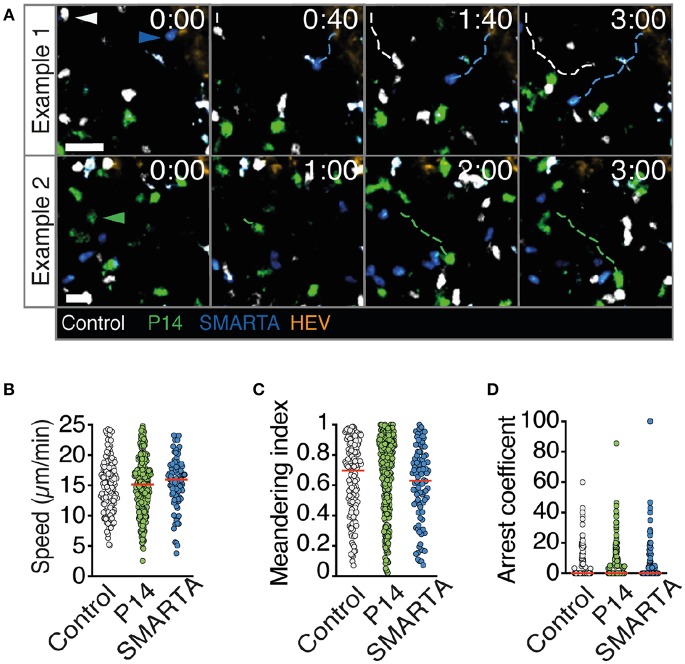
T cell motility parameters in non-infected LNs. (A) Representative 2PM images of control (white), P14 (green), and SMARTA T cell tracks (blue) with HEV (orange) at 96 h after adoptive T cell transfer. Arrowheads point the tracked cell: control (white), P14 (green), and SMARTA (blue). Scale bar, 20 μm. (B–D) Quantification of the 2PM motility parameters: Migration speed (B), meandering index (C), and arrest coefficient (D) of control (gray), P14 (green), and SMARTA T cells (blue). Red lines depict median. Each dot represents a single track. Data are pooled from two independent experiments with a total of three mice. Statistical significance in (B–D) was analyzed by unpaired Mann-Whitney test of control vs. P14 and SMARTA T cells, respectively.